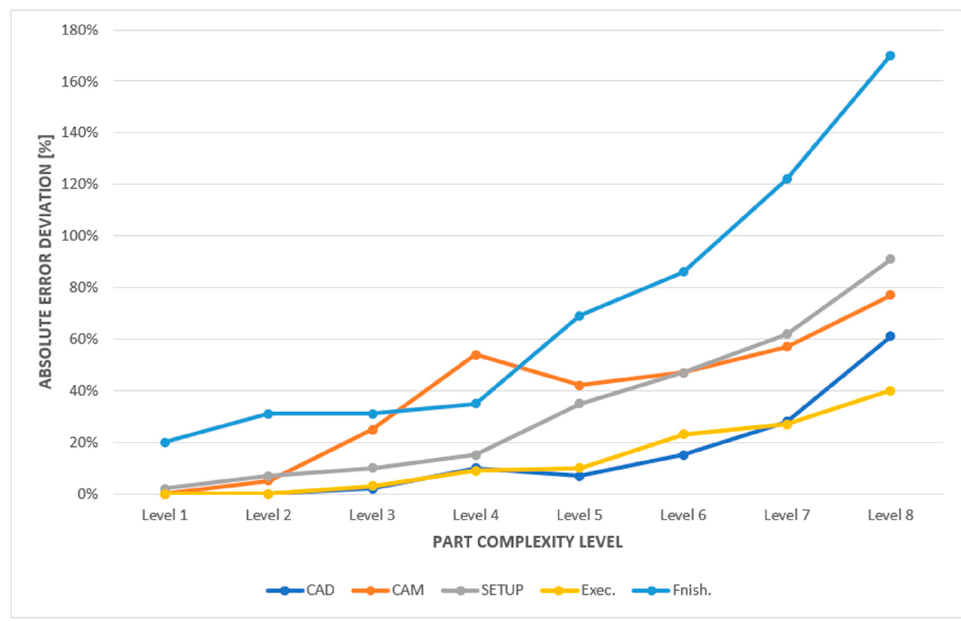
Figure 11. Absolute percentual deviation variation of each part production step, over different part complexity levels.